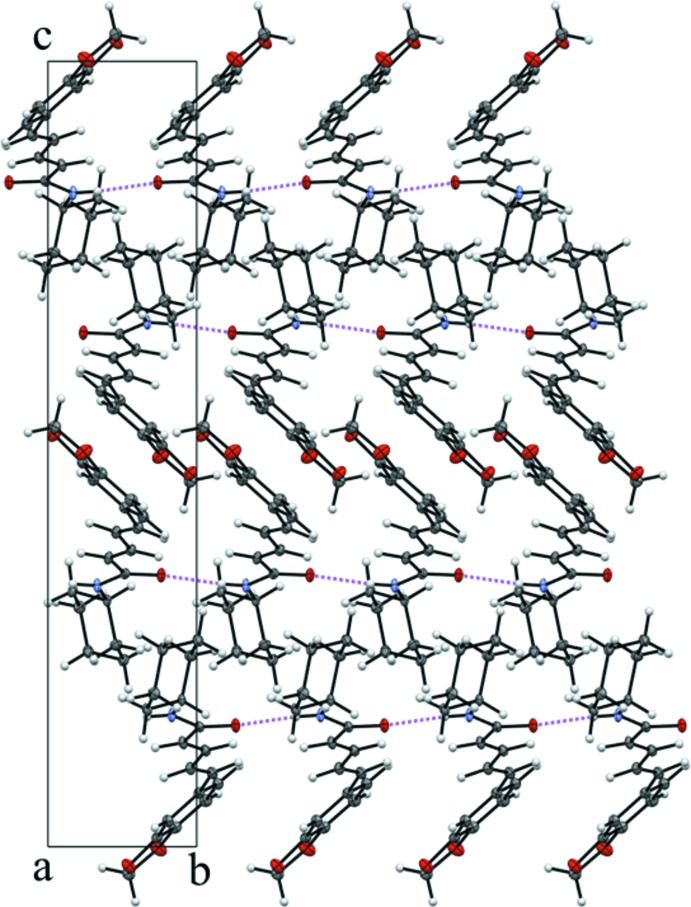
The unit-cell packing for (I) viewed down [100] with hydrogen bonds drawn as dashed lines.